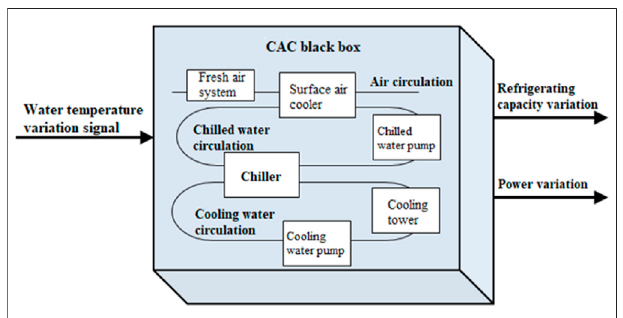
FIGURE 1 | Black box model of central air